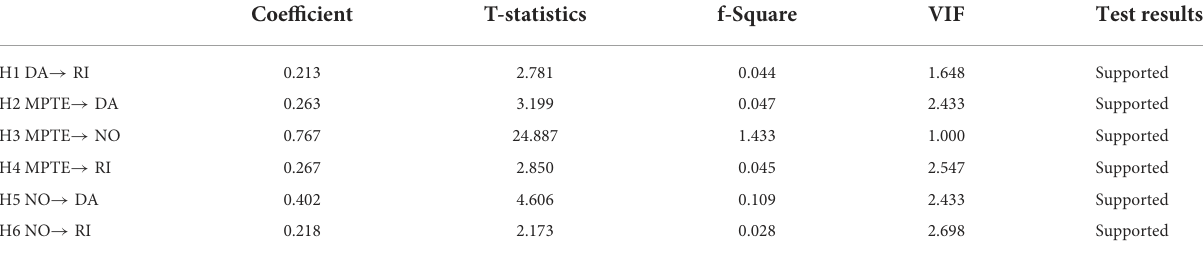
TABLE 5 Results of hypotheses